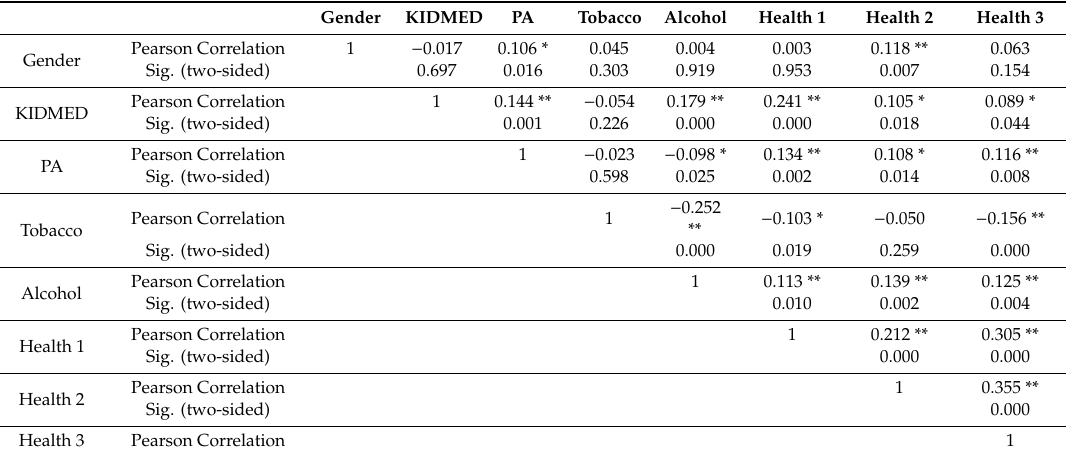
Table 3. Correlations between the di ff erent variables